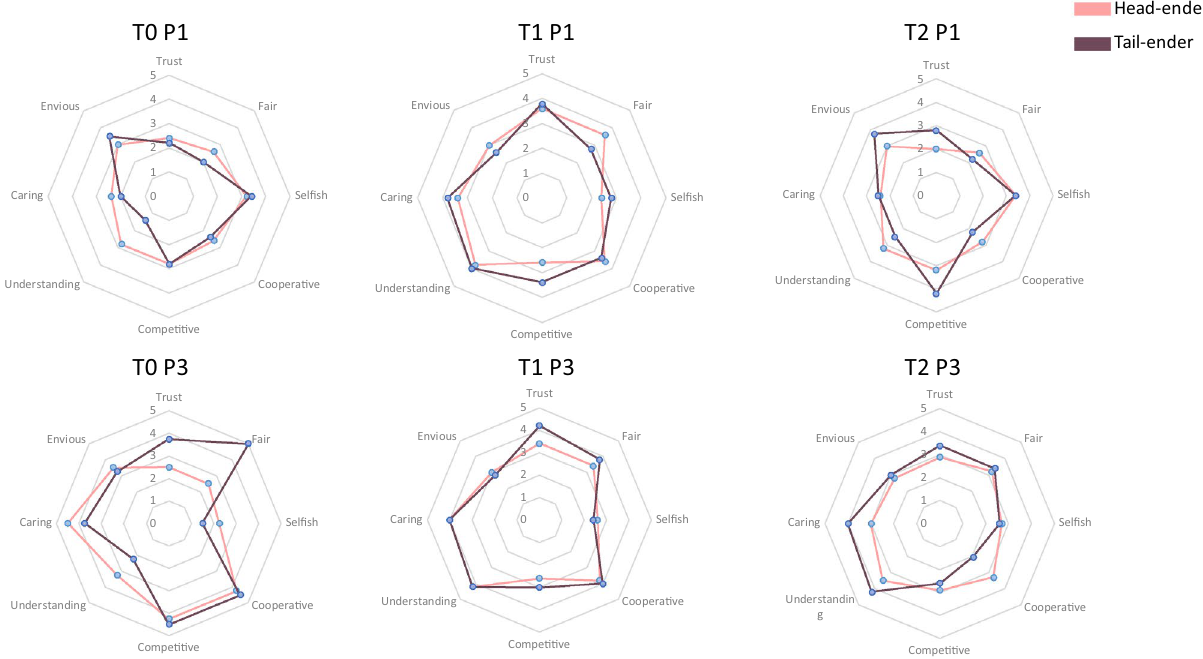
Figure 7. Opinion about others for head and tail enders, per treatment and